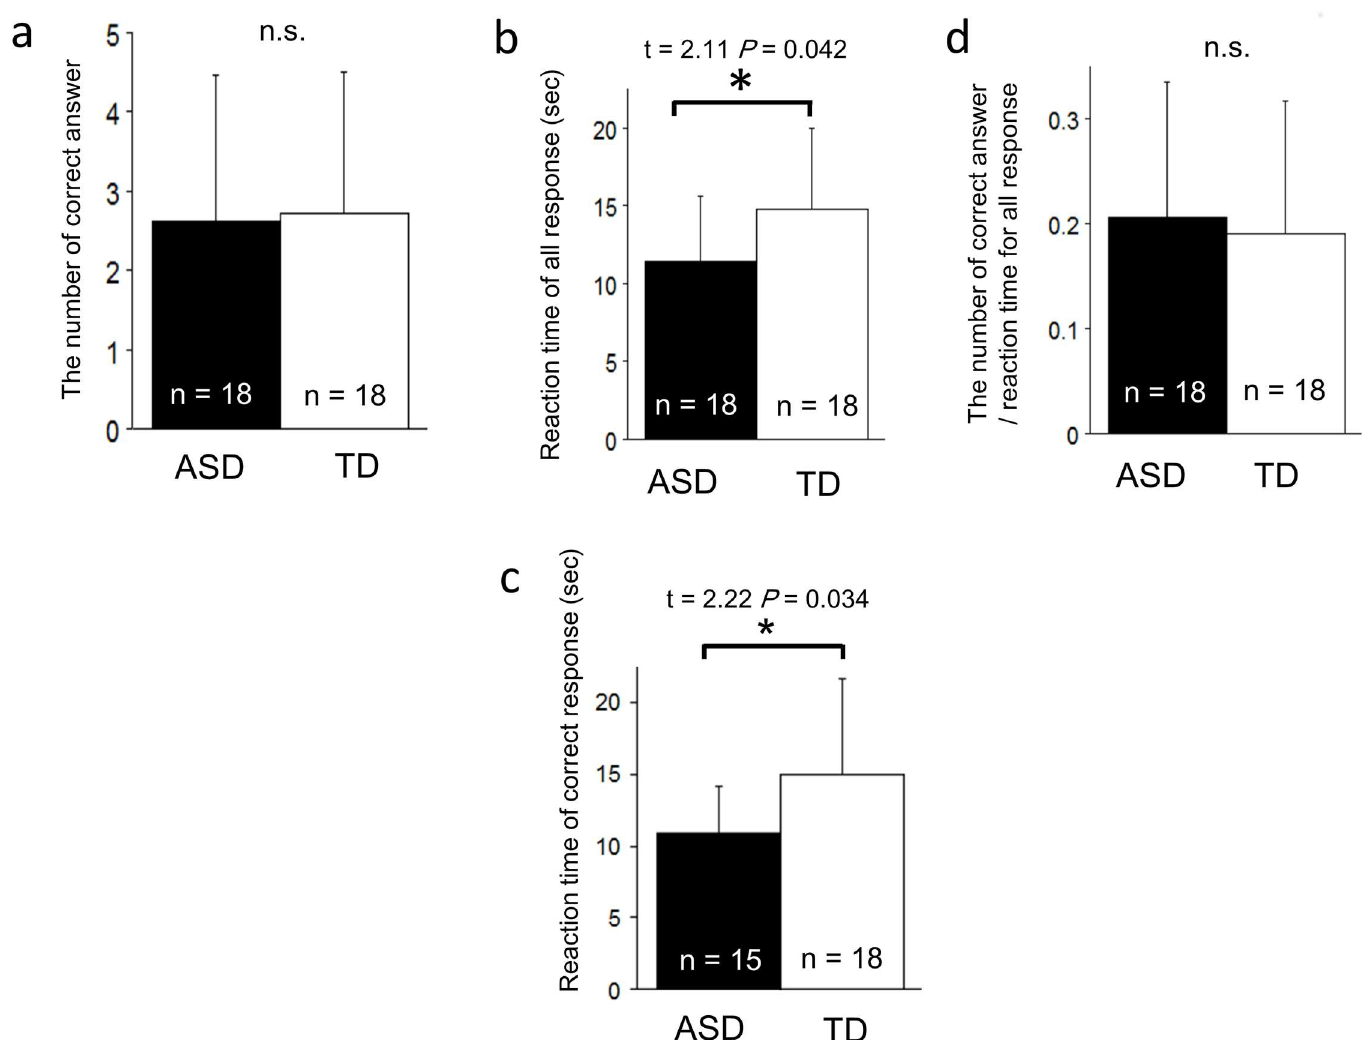
Fig 3. The performanceof TD and AS children on a mentalrotationtask. No significant difference was found for the numberof correctanswers (a) and the efficiencyindex (d).AS childrenresponded more quickly than TD childrenfor all responses includingincorrectanswers (b) and for correctresponses excluding incorrect answers (c).The errorbars represent one